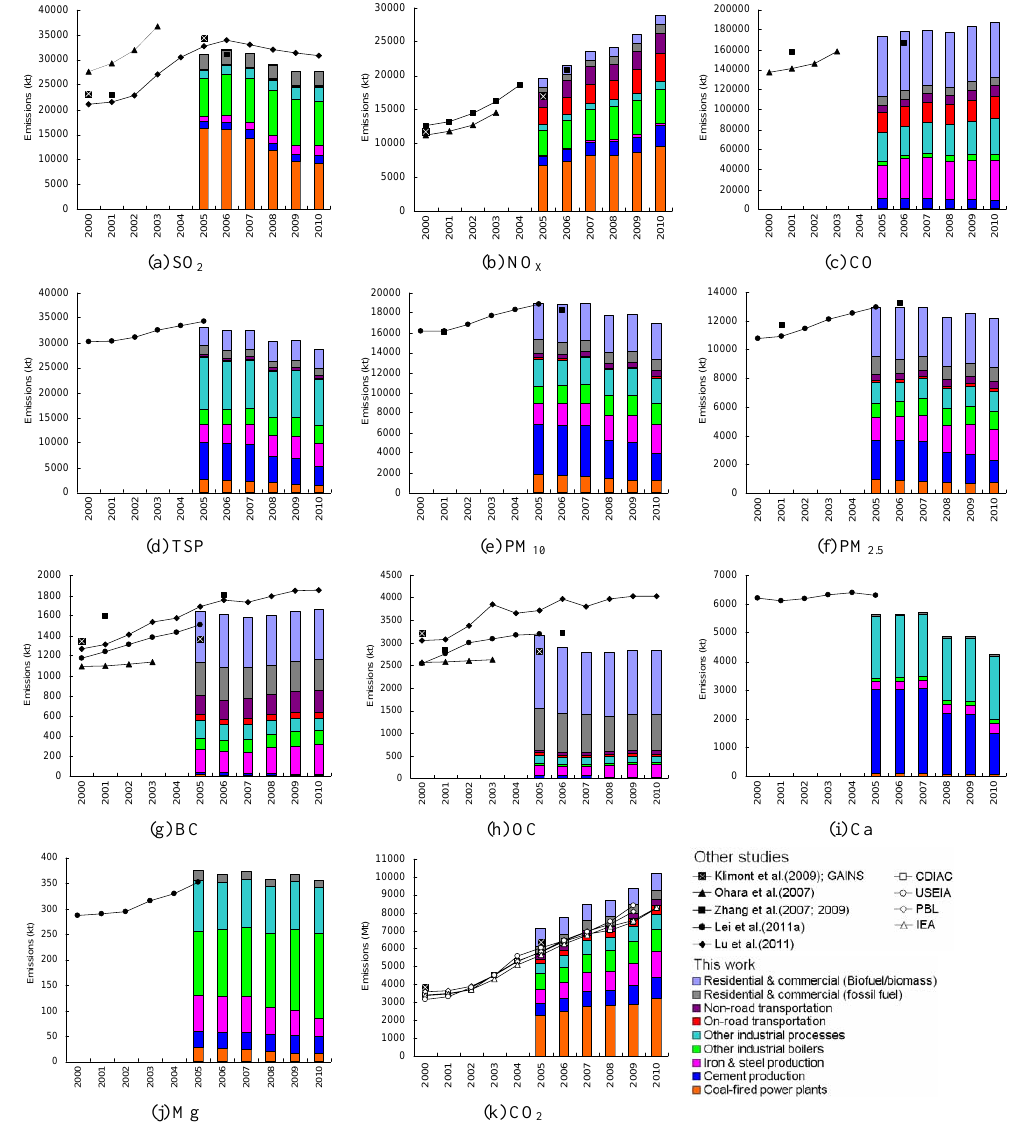
Fig. 3. The annual emissions by sector in China from 2005 to 2010 as well as total emissions from other studies